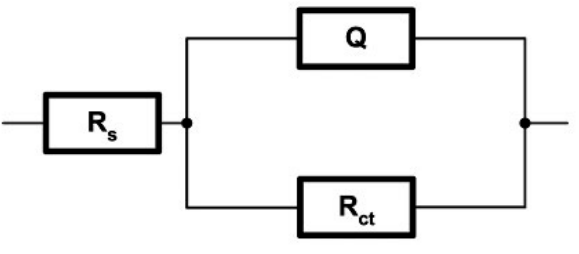
Figure 5. Model of an R(QR) electrical circuit.